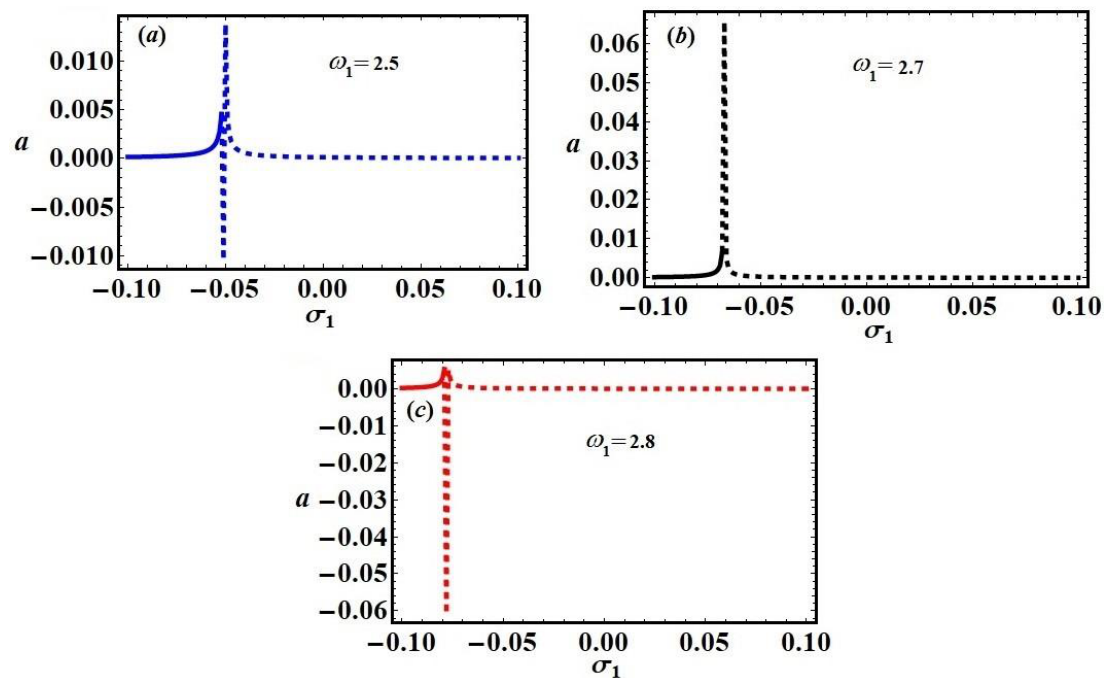
Figure 10. Frequency response of the amplitude a at c 1 = 0.03, σ 2 = 0.003: ( a ) ω 1 = 2.5, ( b ) ω 1 = 2.7, ( c ) ω 1 = 2.8.